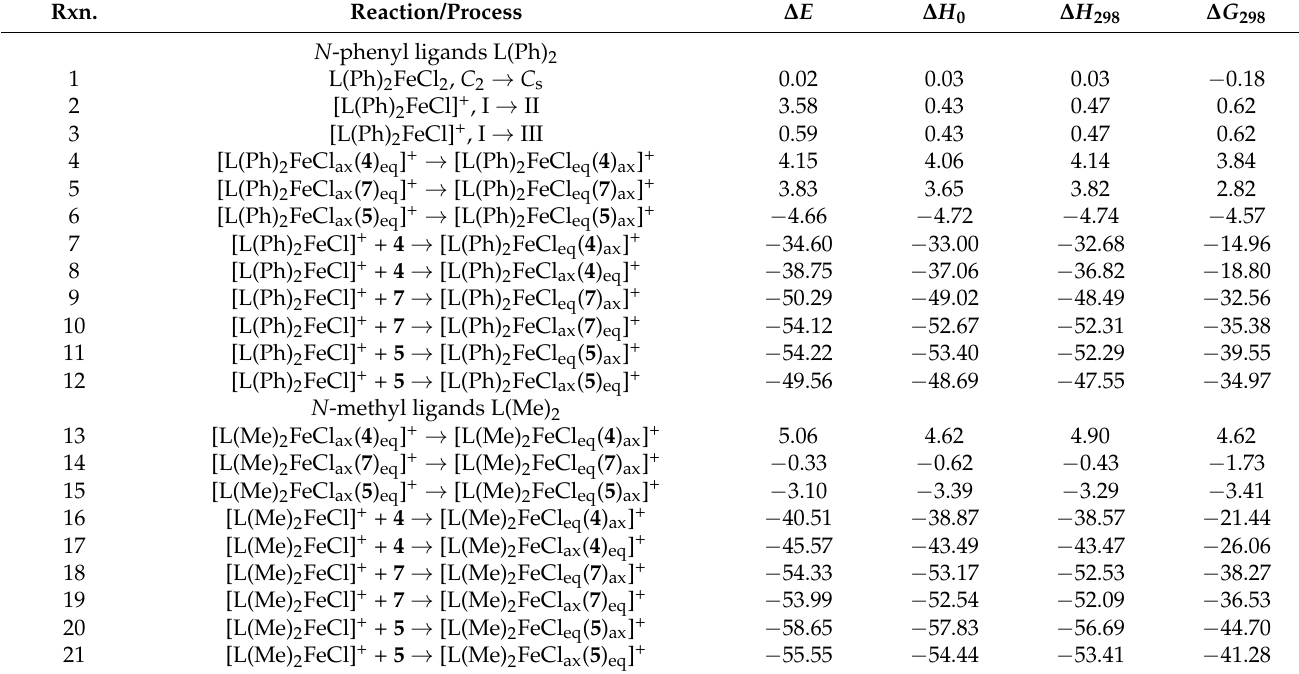
Table 2. Computed Relative and Reaction Energies (kcal/mol, B3LYP/6-31G *).